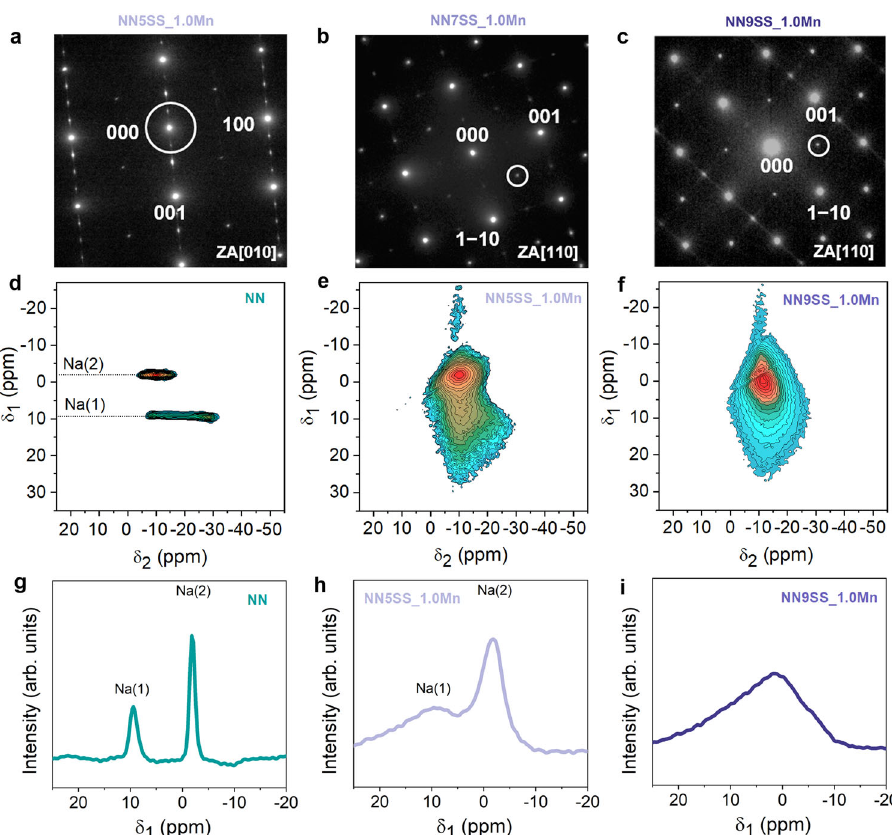
Fig. 3 | Characterization of the local structures. a – c The SAED patterns of the NN5SS_1.0Mn, NN7SS_1.0Mn, and NN9SS_1.0Mn samples recorded along the zone axisof the [010], [110], and [110]direction, respectively.The white circles highlight the selected re fl ections for the bright- fi eld and centered dark- fi eld images in